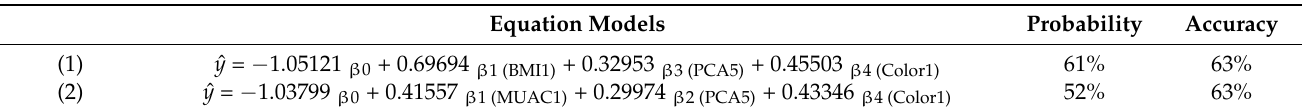
Table 3. Models for the probability of success in predicting the occurrence of any adverse outcome according to maternal nutritional characteristics in